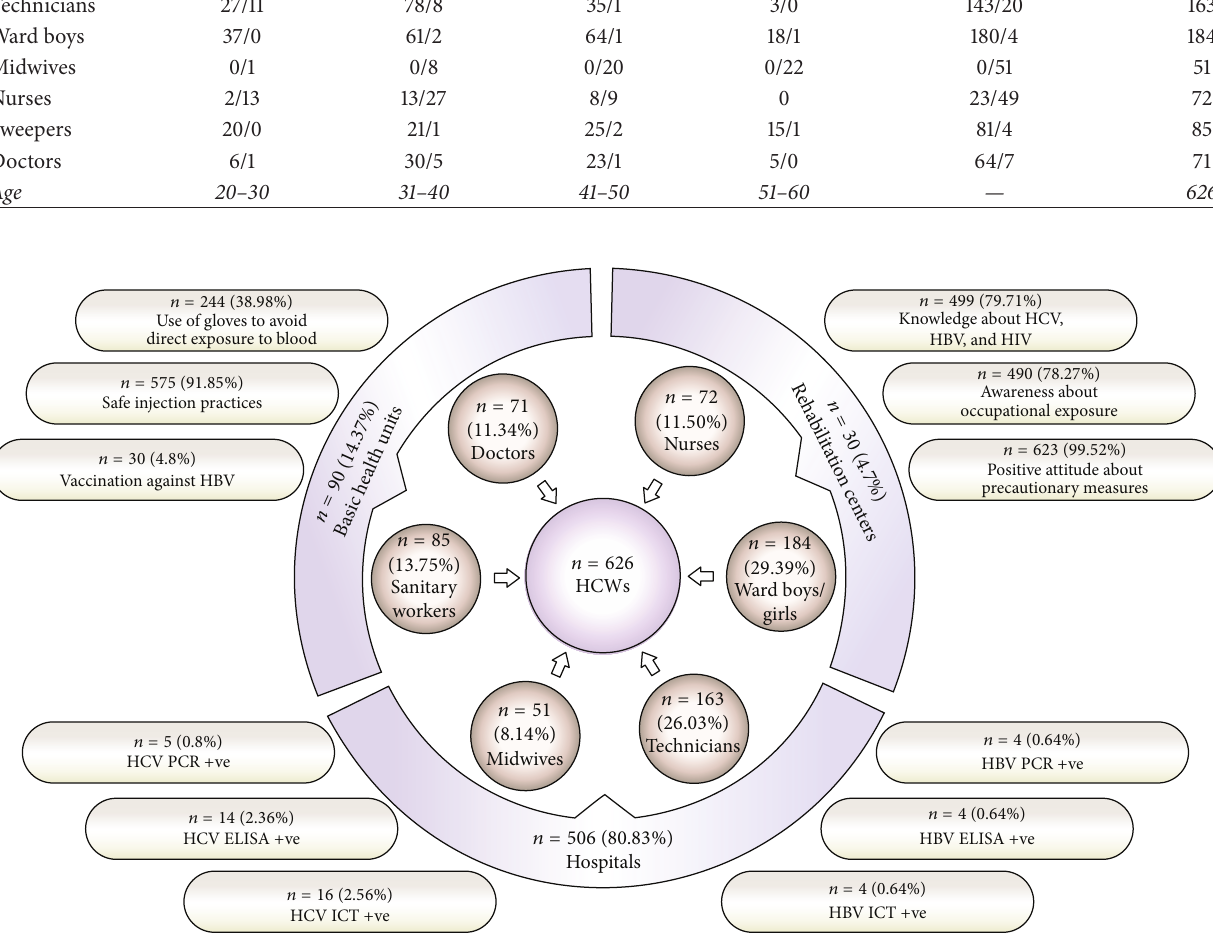
Figure 1: Description of study population along with preventive behaviors and rates of